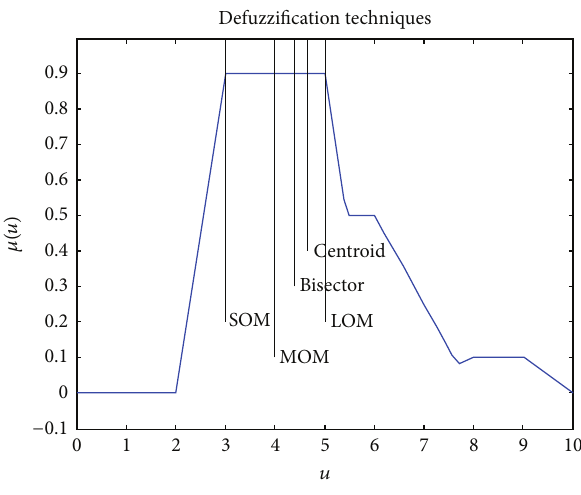
Figure 2: Defuzzification techniques.